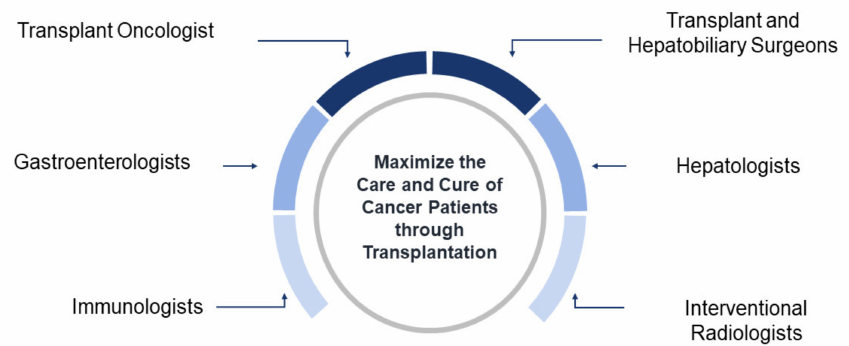
Figure 1. Concept map of transplant oncology. Multidisciplinary collaborative approach to maximize the care of cancer patients through